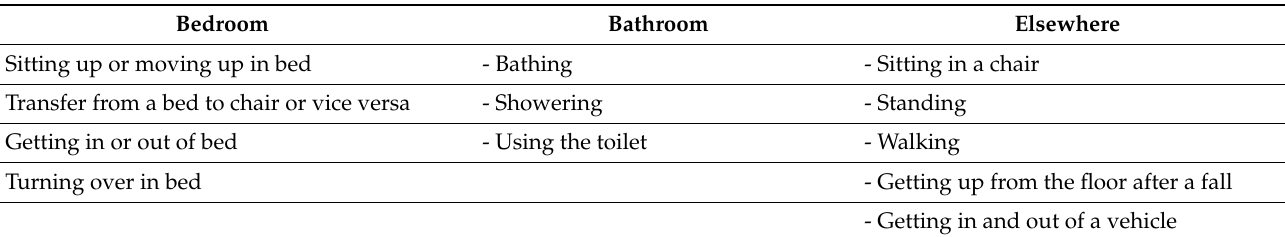
Table 1. Nurses’ activities for patients demanding physical